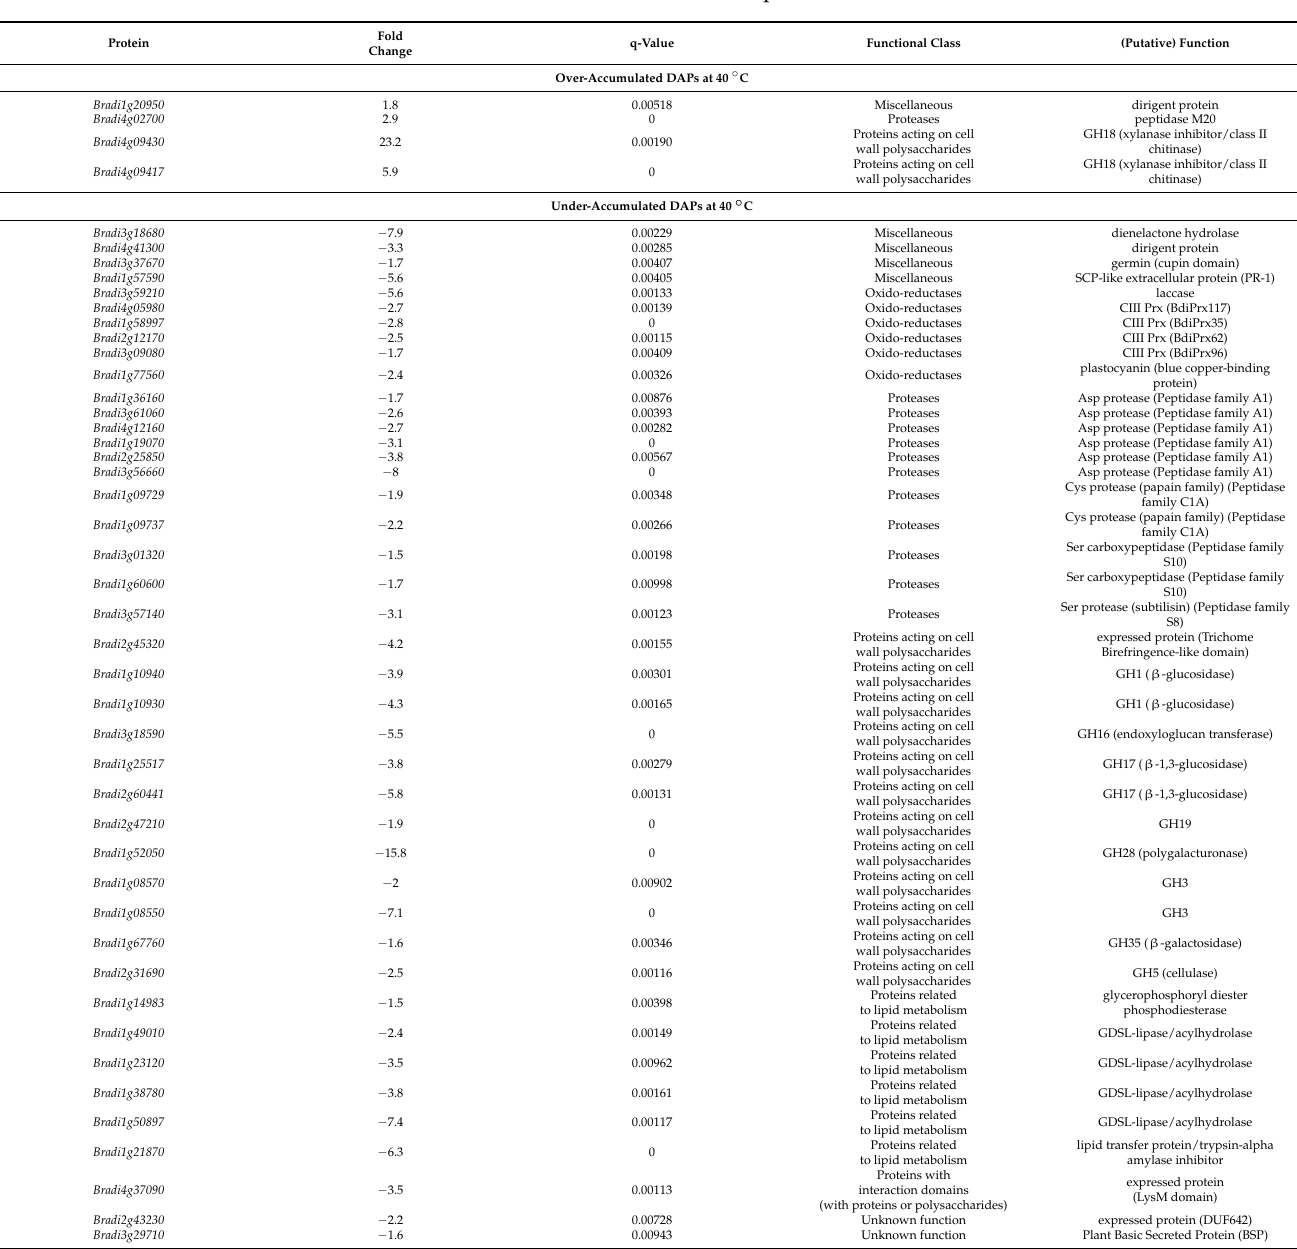
Table 3. DAPs for the 40 ◦ C treatment compared to the